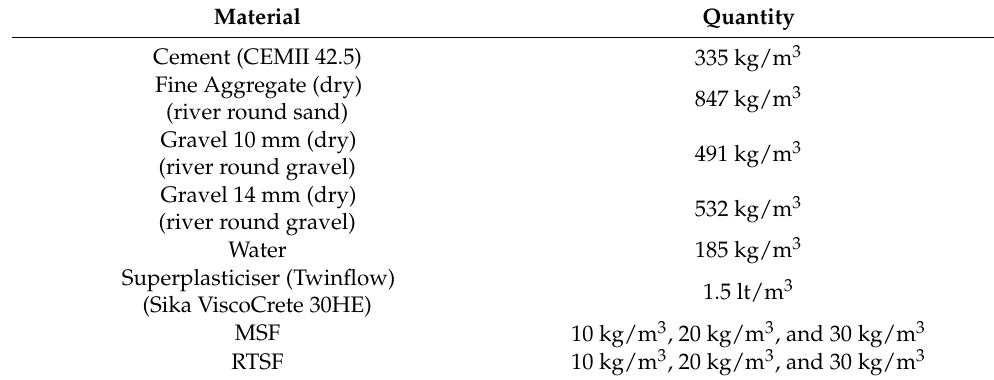
Table 1. Concrete mix proportions.